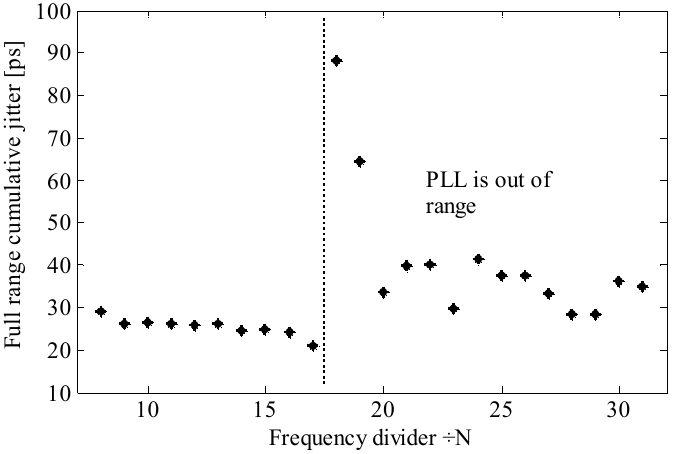
Figure 7. Cumulative jitter of the in-pixel VCRO, measured for a time window equal to the TDC full range; the frequency control voltage of the VCRO is connected to the internal reference provided by the phase-locked loop (PLL) loop filter.